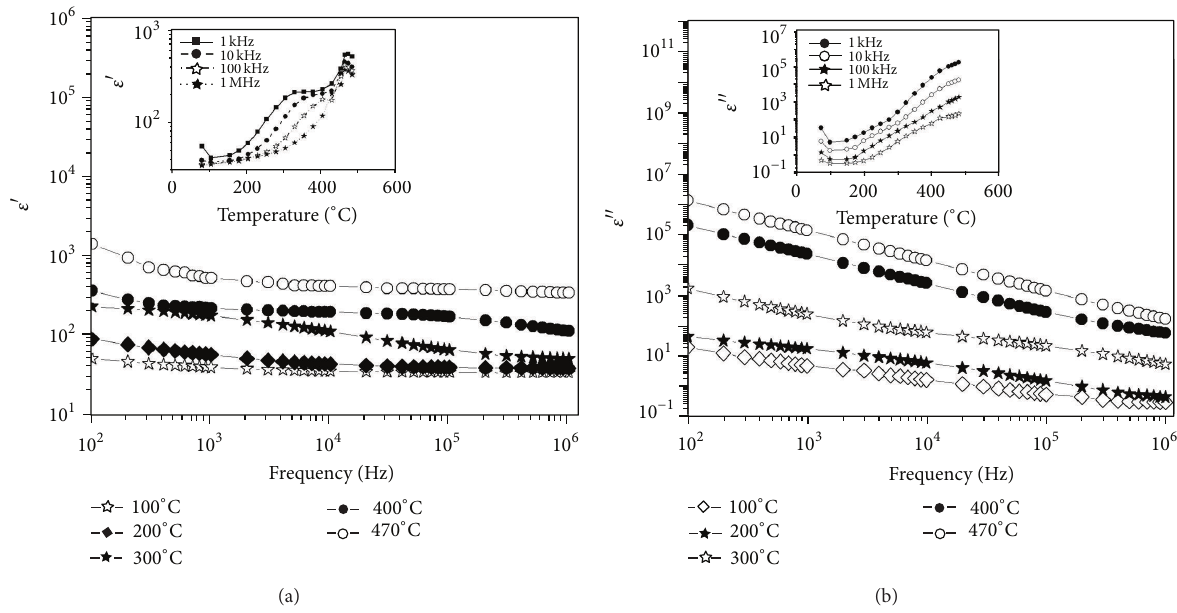
Figure 3: (a) Temperature dependence of dielectric constant (real) at different frequencies. (b) Temperature dependence of dielectric constant (imaginary) at various frequencies. Insets show the temperature dependence of real and imaginary parts of the dielectric